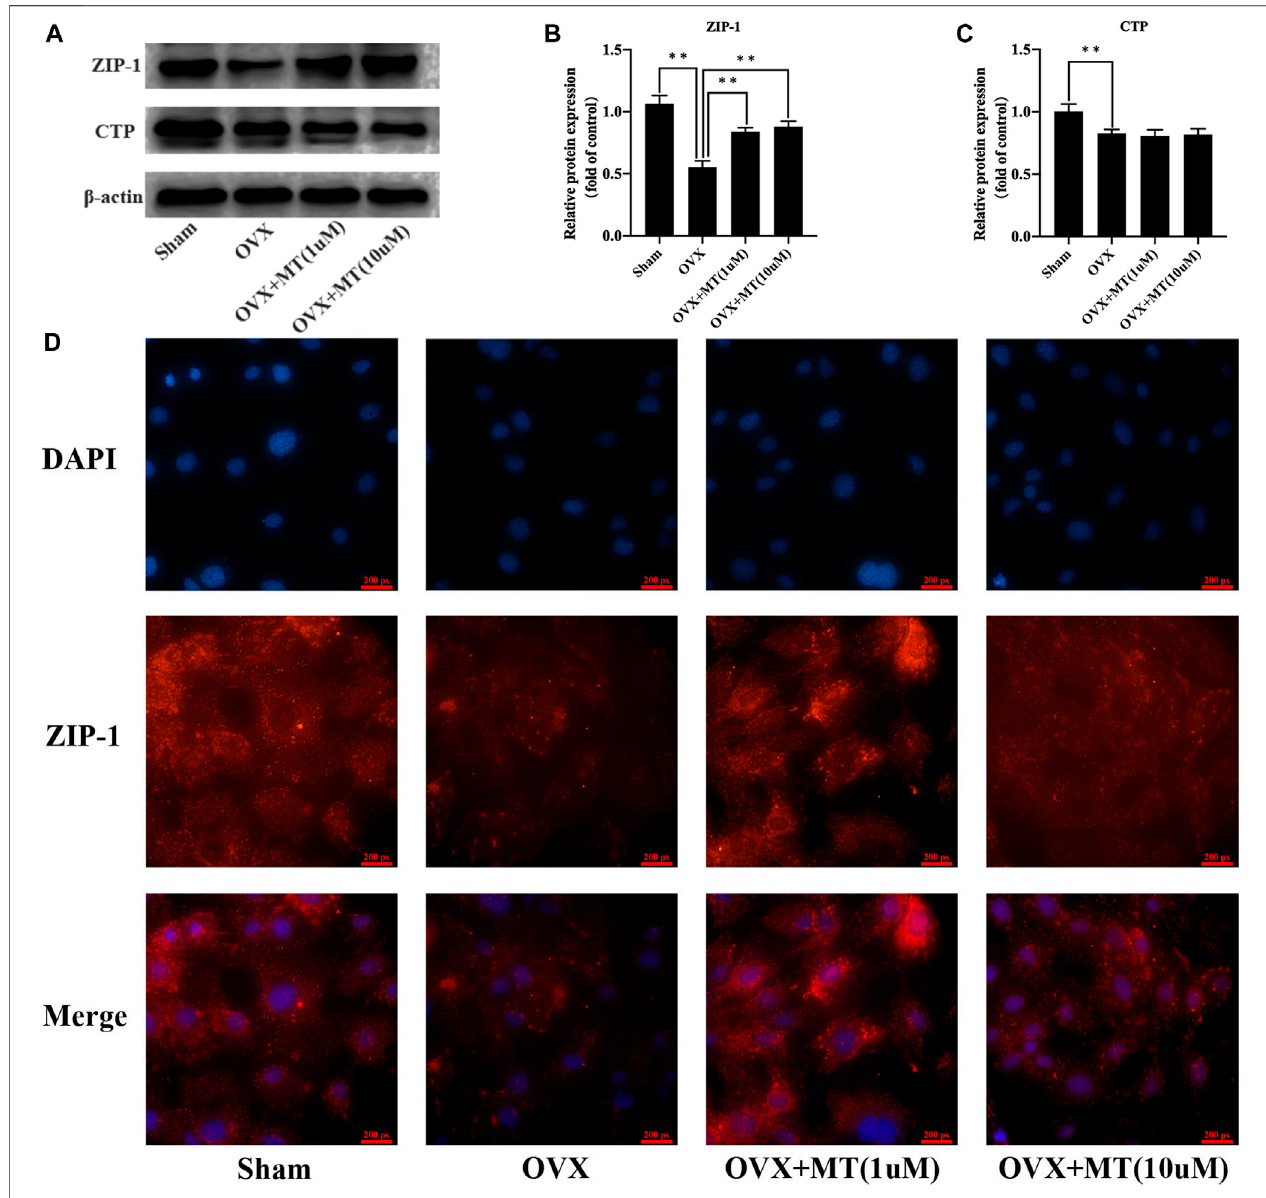
FIGURE3 | Melatonin enhances the ZIP-1 expression in osteoblasts. (A) western blotting results ofZIP-1 (34kDa), CTP (34 kDa), and β -actin (42 KDa) expression indifferentcellgroups, (B) relativeexpressionvalueofZIP-1, (C) relativeexpressionvalueofCTP,and (D) immuno fl uorescenceresultsofZIP-1expressionindifferentcell groups, the expression ofZIP-1inOVXwassigni fi cantly lowerthan thatinsham group, and themelatonin treatment couldsigni fi cantly promote theexpression ofZIP-1. *P-value < 0.05, **P-value < 0.01.